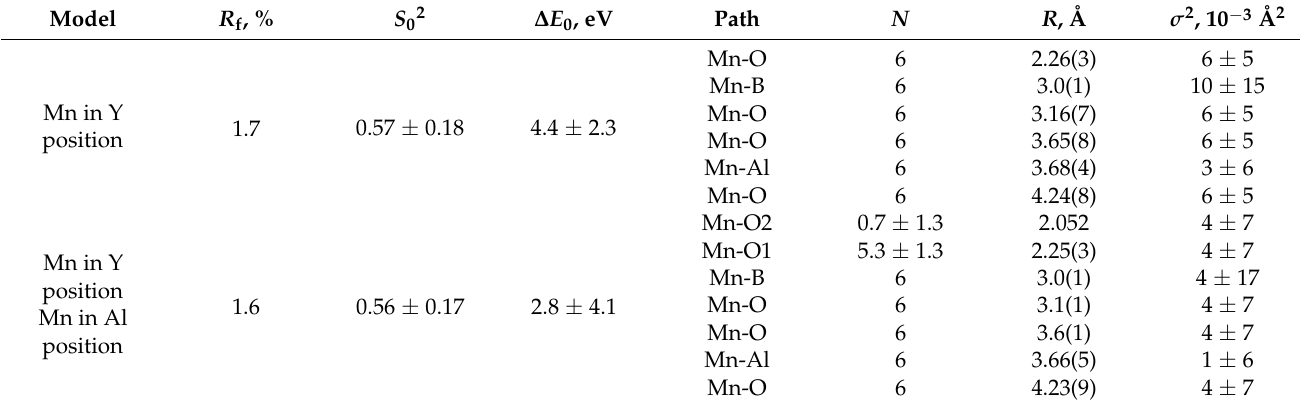
Table 2. Parameters of the nearest environment of Mn obtained from EXAFS data.